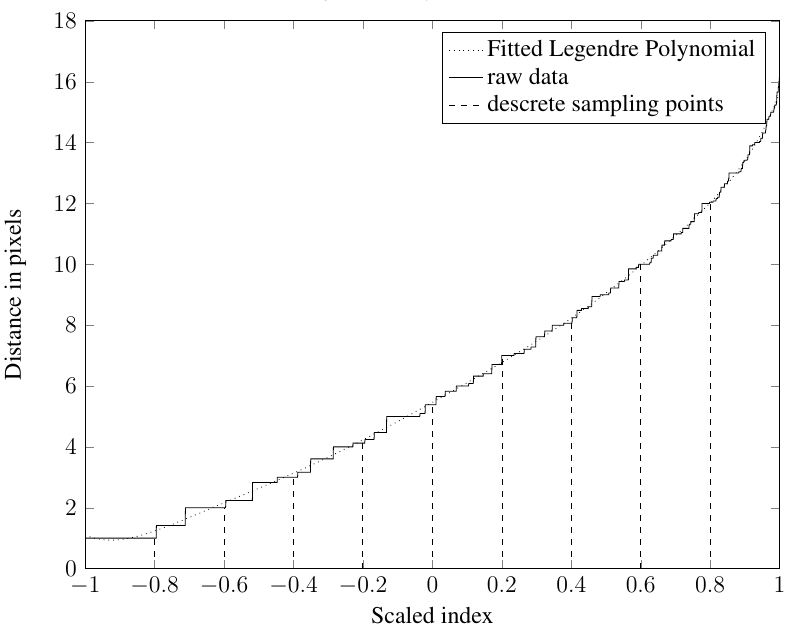
Figure 6. Visualization of data together with a fitted 9 order Legendre polynomial and descrete sampling